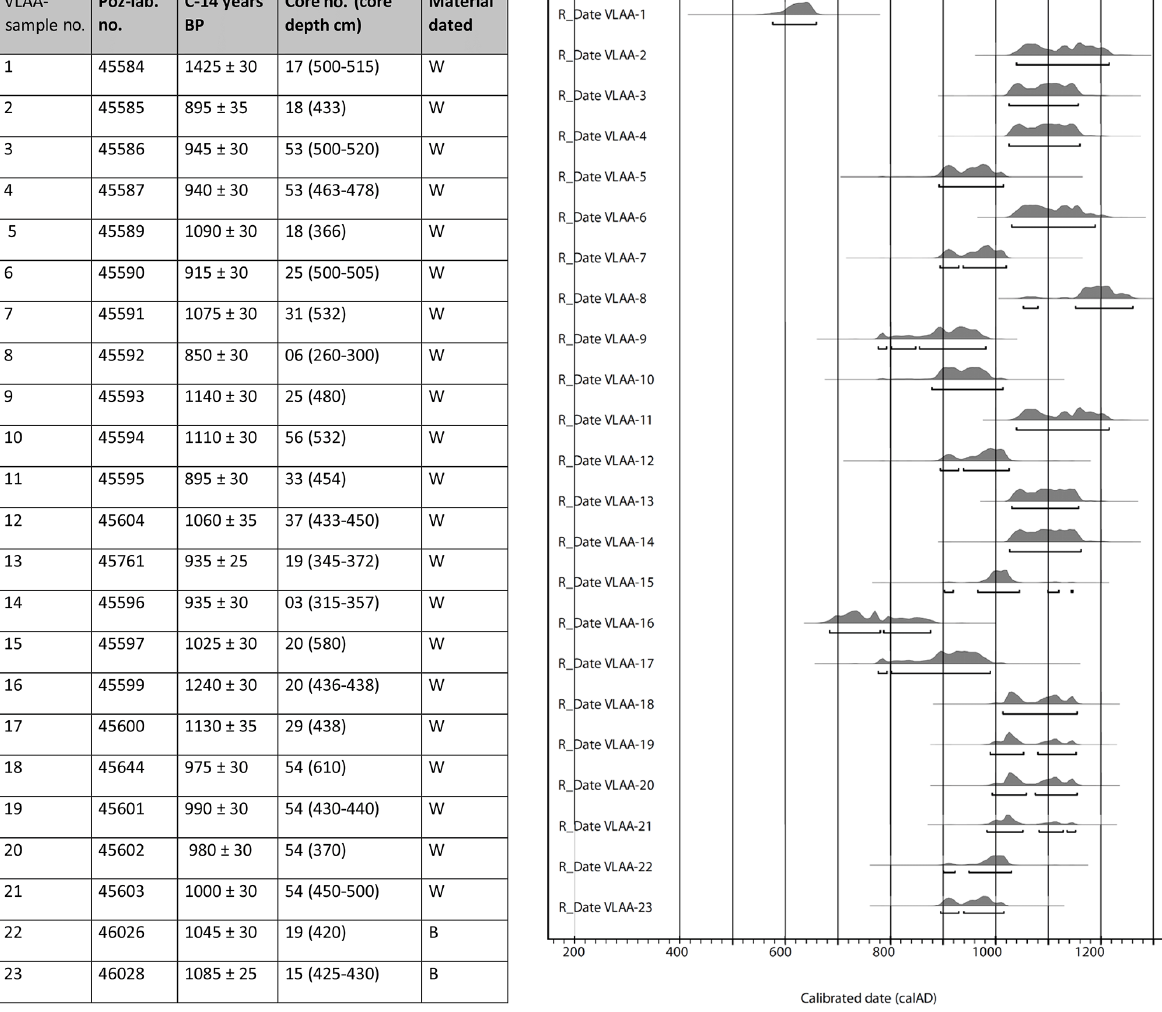
XRF values were sampled on 10 cores through measure- ments with a handheld Thermo Scientific Field Mate Niton XRF